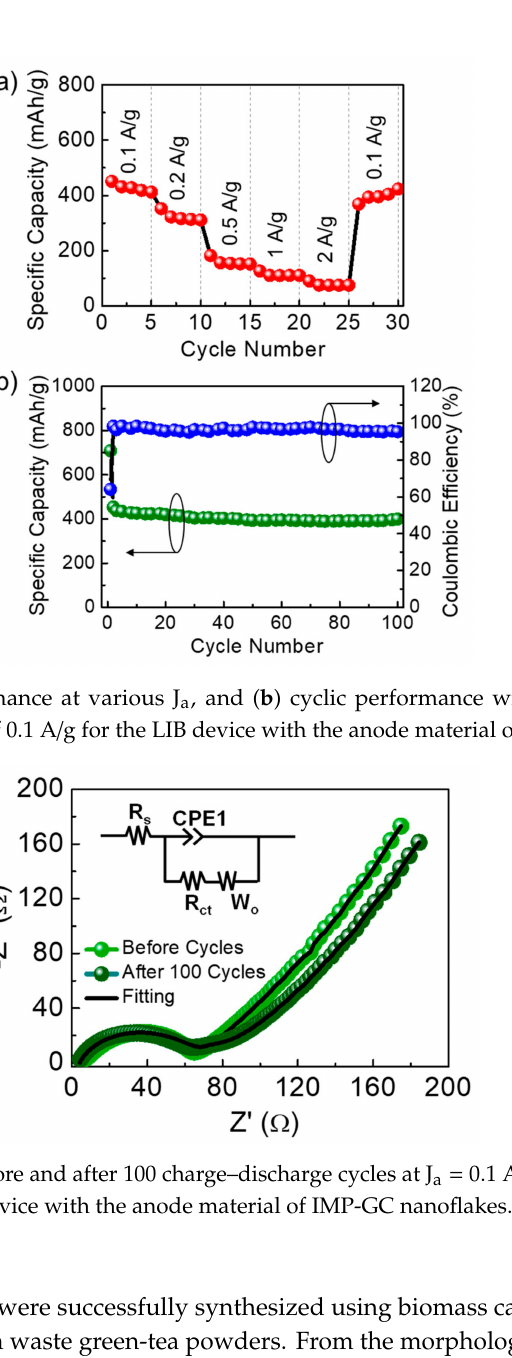
Figure S1: Thermogravimetric analysis of the green tea powder ash; Figure S2: T-plot of the IMP-GC nanoflakes; Figure S3: Field-emission SEM images of the IMP-GC nanoflakes activated at (a) 700 ◦ C, (b) 800 ◦ C, and (c) 900 ◦